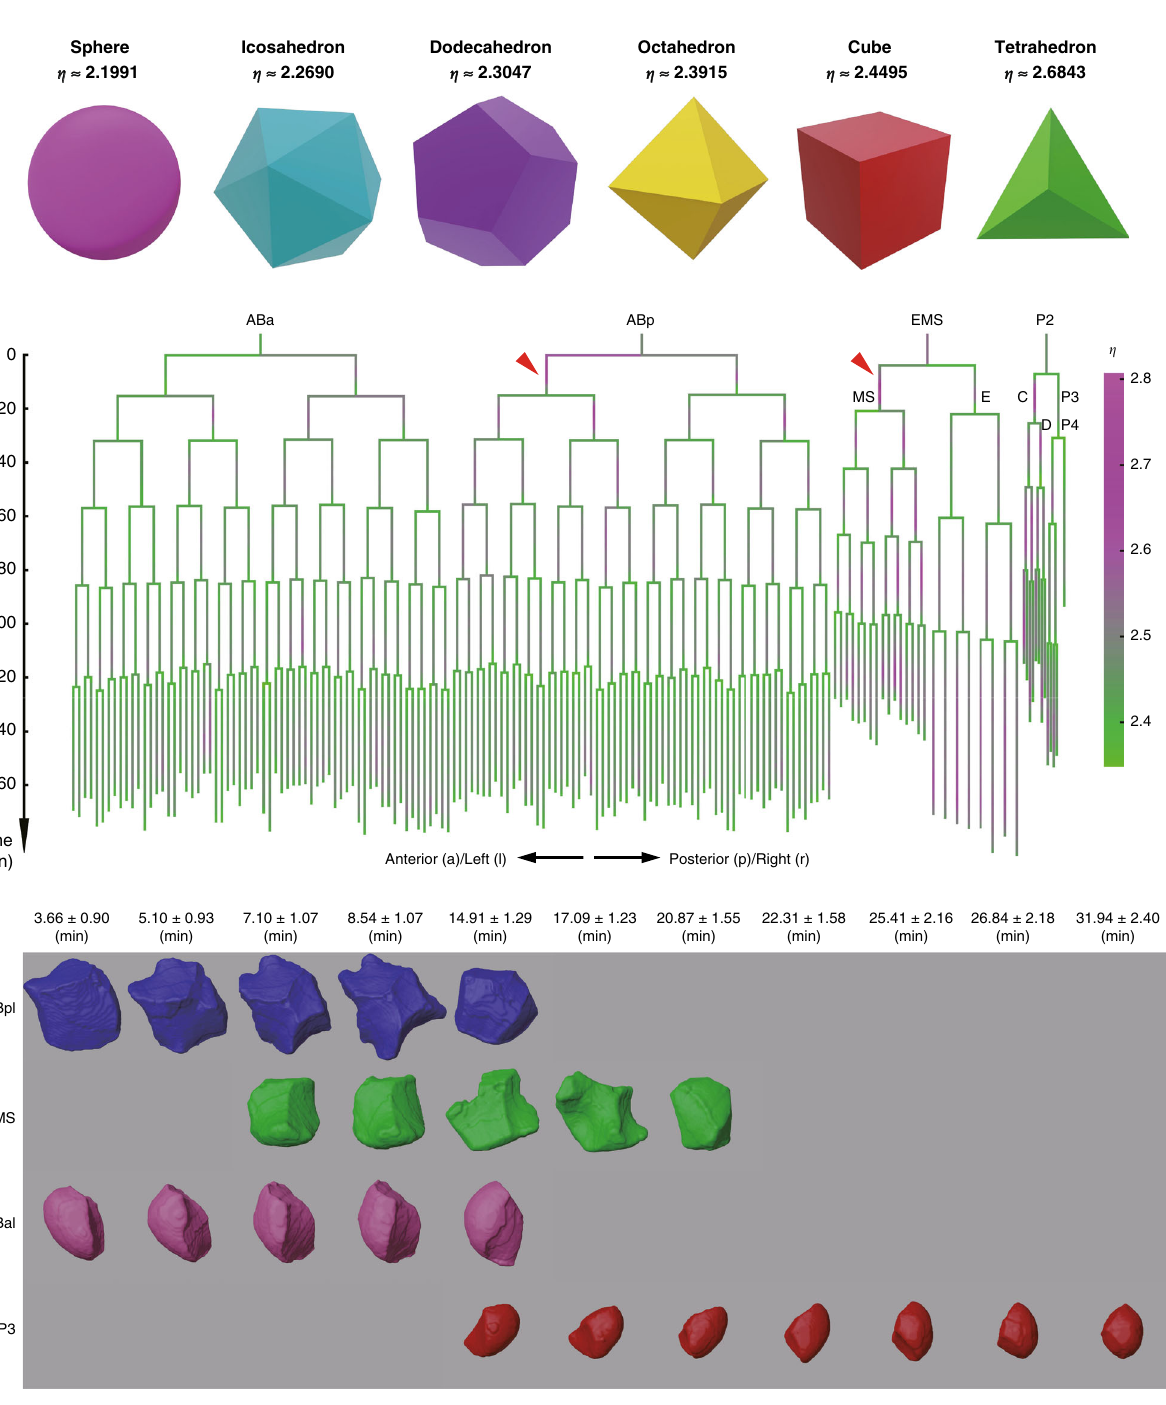
Fig. 4 Cell shape irregularity during C. elegans embryogenesis. a Dimensionless irregularity scores, η , for a sphere, icosahedron, dodecahedron, octahedron, cube, and tetrahedron. b Distribution of cell shape irregularity over development shown in a cell lineage tree, with the two most irregular cells, ABpl and MS, indicated by red triangle. The color scheme denoting the level of shape irregularity is shown on the right. Source data are provided as a Source Data fi le. c Time-lapse 3D cell shape dynamics of ABpl (blue), MS (green), ABal (pink), and P3 (red) derived from embryo Sample 05. Horizontal and vertical axes represent anterior – posterior (A – P) and dorsal – ventral (D – V) axes, respectively. Dynamics of 3D shape is shown over developmental timings (mean± standard deviation) indicated at the top (Supplementary Data